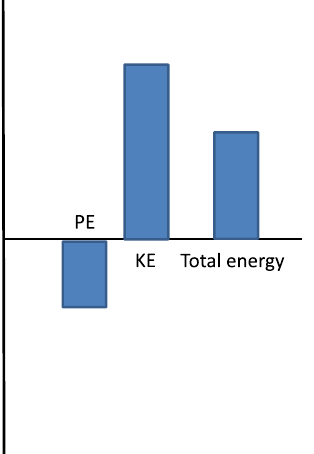
FIG. 3. An example of an energy bar chart in which the kinetic energy is greater than the total